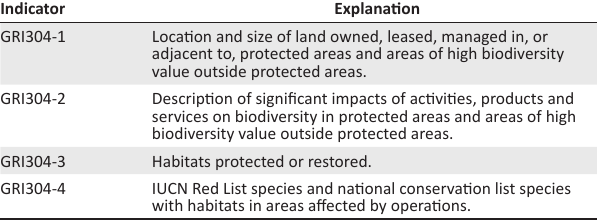
TABLE 1: Global Reporting Initiative biodiversity indicators. Indicator